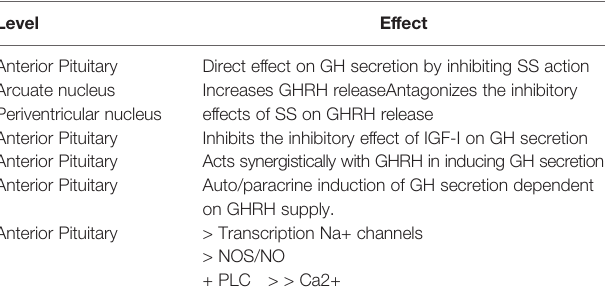
TABLE 2 | Ghrelin and pituitary GH secretion.